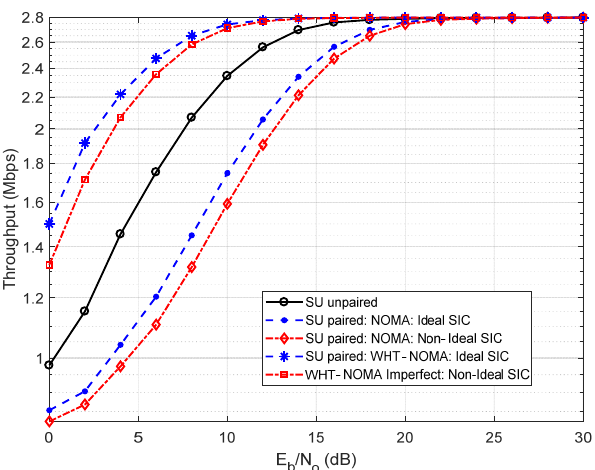
Figure 11. Throughput performance using QPSK modulation; NOMA vs. WHT–NOMA, power allocation: SU (SCU) = 0.4 and MU (SEU) = 0.6.